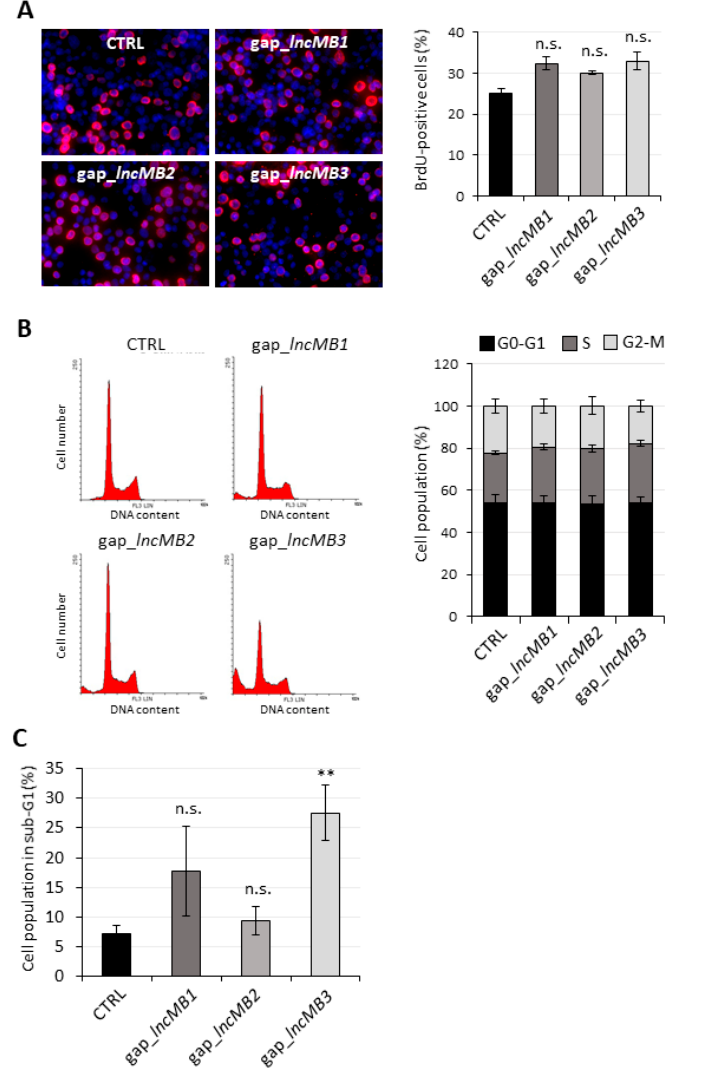
Figure 9. DOX-untreated D283-OMO cell proliferation and cell cycle are not affected by lncMB1 , lncMB2 and lncMB3 knock-down. ( A ) Left panel: representative pictures of DOX-untreated D283-OMO cells knocked down for lncMB1 , lncMB2 and lncMB3 and subjected to a BrdU incorporation assay, compared to scramble-transfected cells. Magnification 10×. BrdU-positive cells are visualized in red, nuclei are counterstained in blue, merge signals appear as pink. Right panel: quantification of BrdU-incorporating DOX-untreated D283-OMO cells knocked down for lncMB1 , lncMB2 or lncMB3 , compared to scramble-transfected (CTRL) cells. Data (means ± SEM) from 6 view-field/replicate are expressed as a percentage over the total number of cells. BrdU-positive cells and nuclei were counted with ImageJ. N = 3. ( B ) Left panel: representative cell cycle analysis by flow cytometric determination of PI-stained DOX-untreated D283-OMO cells upon depletion of lncMB1 , lncMB2 and lncMB3 , compared to control cells. DNA content and cell number are reported on x - and y -axes of the diagrams, respectively. Right panel: quantification of the of PI-stained DOX-untreated D283-OMO cells (knocked down for lncMB1 , lncMB2 or lncMB3 ) according to their distribution in G0/G1, S and G2-M cell cycle phases, established by flow cytometry. Scramble-transfected (CTRL) cells were used as control. Data (means ± SEM) are expressed as percentages over the total cell number. N = 4. Statistical test (two-tailed Student’s t -test) was performed by comparing, for each phase of the cell cycle, cell percentages between experimental vs. control conditions. ( C ) Quantification of cells in the sub-G1 phase (data from Figure 4, left panel). Data (means ± SEM) are expressed as percentages over the total cell number. N = 4, ** p ≤ 0.01 (two-tailed Student’s t